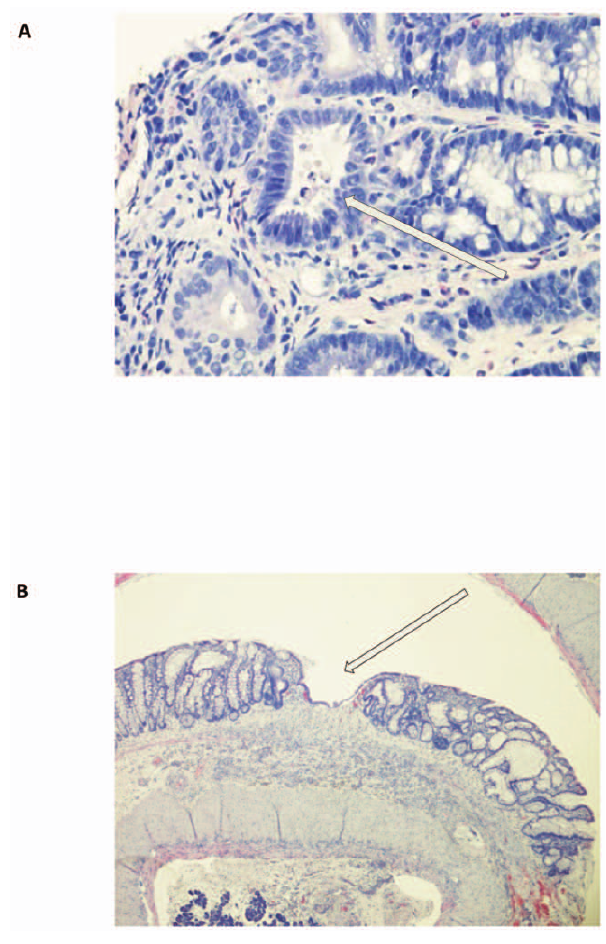
Figure 4. Histologic appearance of an endoscopic biopsy and whole colon specimen. (A) Endoscopic biopsy collected at T7 showing evidence of a crypt abscess (arrow), and mucosal gland distortion. Objective x40. (B) Histologic image of a whole colon specimen collected at termination of the study (T12) identifying distorted mucosal glands, and an ulceration with completed reepithe- lialization and underlying submucosal inflammation (arrow). Objective x4. The slides were stained with hematoxylin and